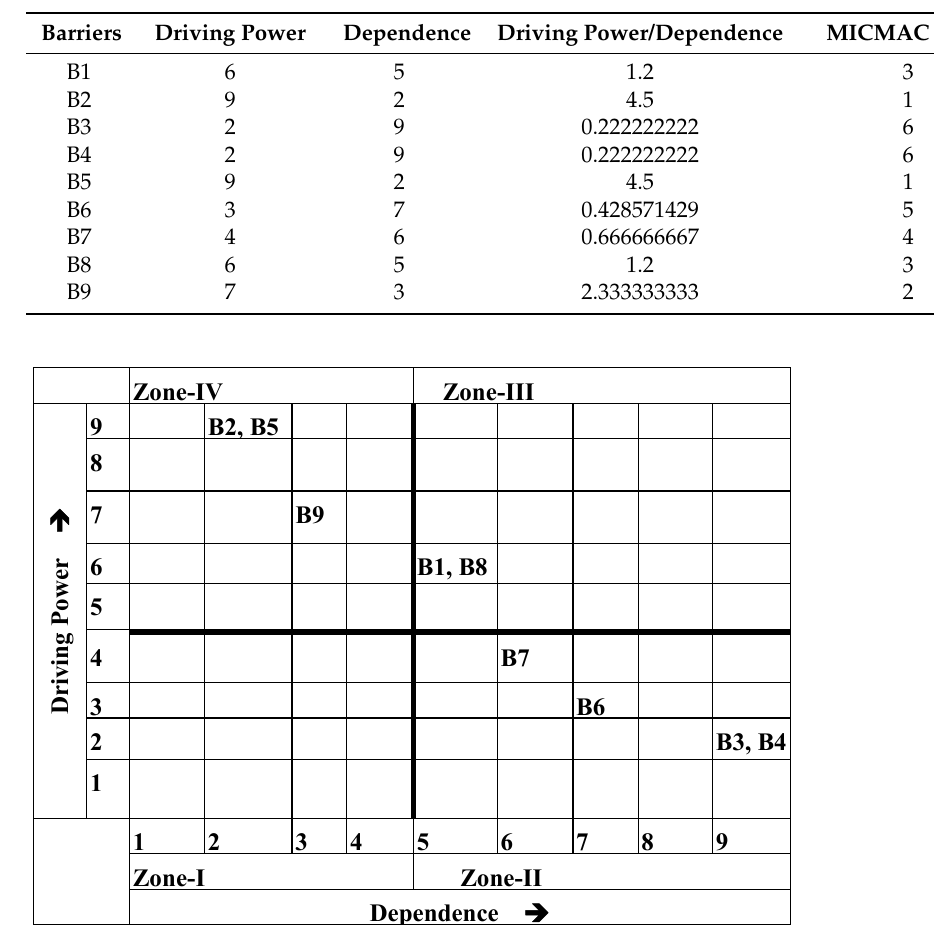
Figure 3. Result of MICMAC analysis of the barriers.